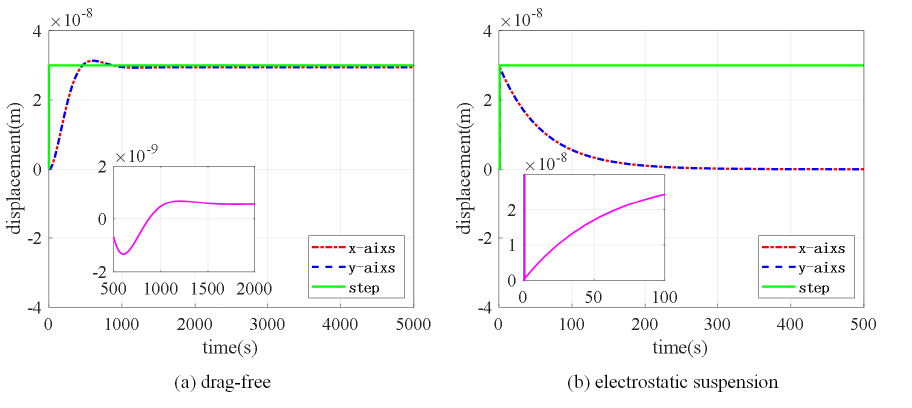
Figure 7. Tracking of step signal: ( a ) outer-loop, ( b )